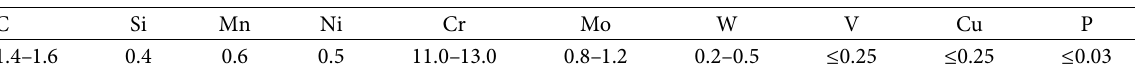
Table 2: Chemical composition of SKD 11.